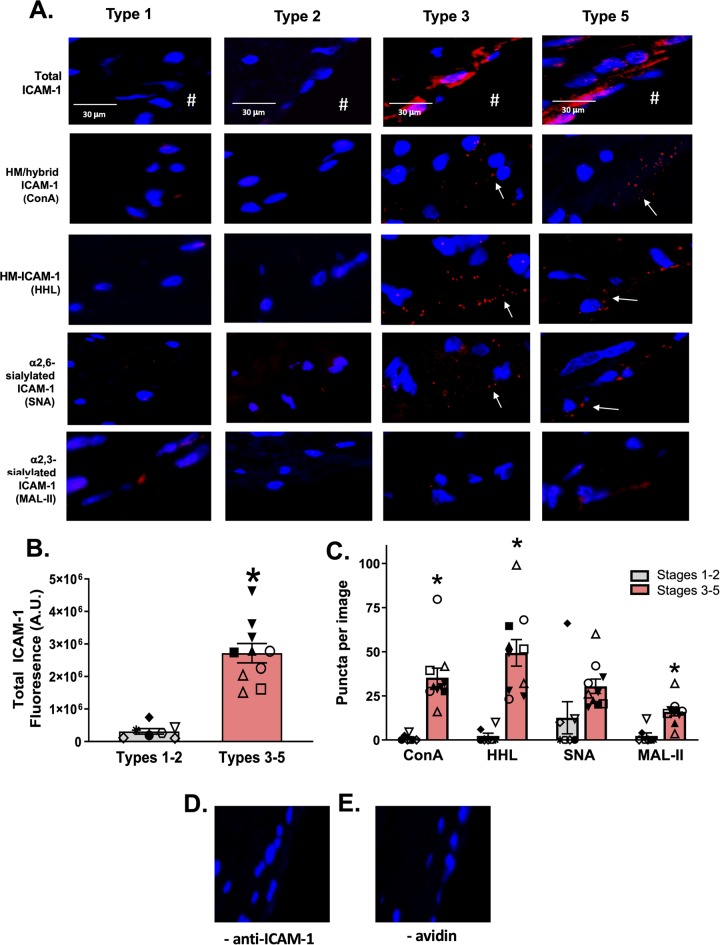
HM / hybrid ICAM-1 is increased in human atherosclerosis.Panel A shows representative images of total ICAM-1 (red staining) and specified N-glycoforms in human vessels with lesions spanning types 1–5. Red puncta represent positive PLA staining (as indicated by arrows). Panel B shows the quantification of total ICAM-1 in early (1–2) and late (3–5) disease stages. Each symbol represents a different patient, with same symbol representing multiple vessels from the same patient. Data are mean ± SEM, n = 7–10. * p<0.05 compared to types 1–2 via unpaired t-test. Panel C shows the quantification of HM / hybrid, HM, α-2,6-sialylated, and α-2,3-sialylated ICAM-1 puncta in early (1–2) and late (3–5) disease stages. * = p<0.05 compared to early stage lesions by t-test. Data are mean ± SEM. n = 7–10. Panels D and E show staining of lesion areas when the anti-ICAM-1 antibody or avidin were excluded.